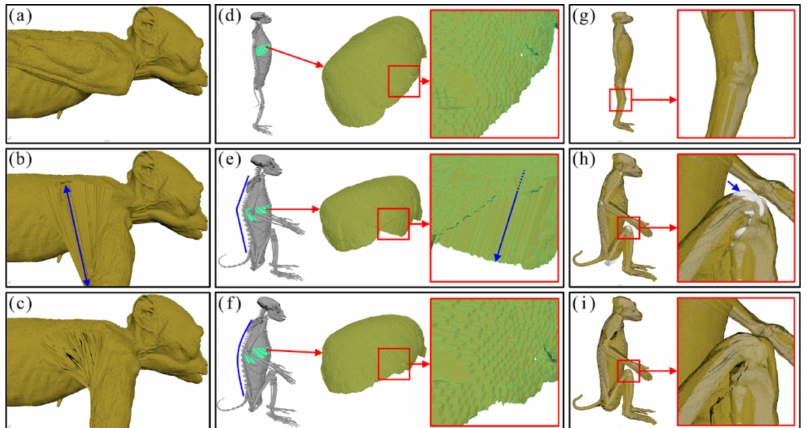
Figure 2. Three types of surface models with abnormal shapes under changing positions. While changing ( a ) the anatomical position of the surface models into ( b ) the quadrupedal position, the skin meshes of the axilla expand abnormally (blue arrow). The meshes of abnormal shape are repaired manually ( c ). When changing ( d ) the anatomical position of the surface models to ( e ) a sitting position by the flexion (blue line) of only a vertebral joint, ( e ) the meshes of the liver intrude on each other (blue arrow). ( f ) The invasion is prevented by a flexion (blue curve) of all vertebral joints. When changing ( g ) the anatomical position of the surface models to a sitting position, ( h ) the meshes of the femur invade the skin in the knee joint. ( i ) This invasion is repaired by adjusting the improper influence value of skin in